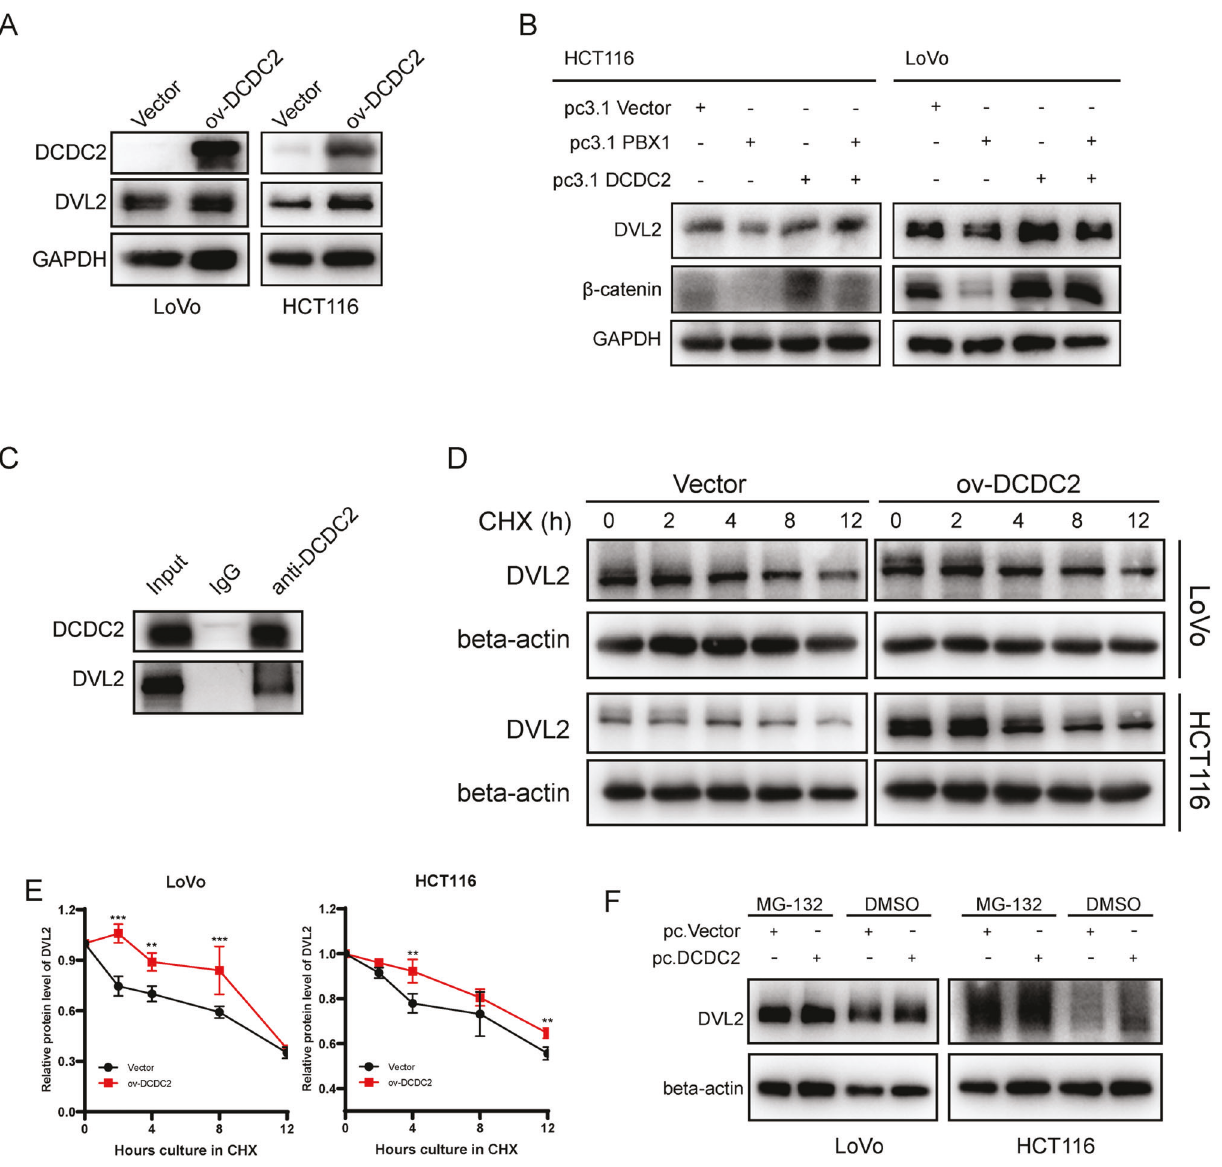
Fig. 7 PBX1-DCDC2 axis controlled Wnt pathway in CRC. A DVL2 decreased under DCDC2 overexpression as measured by western blotting assay. B Western blotting assays detected the DVL2 and β -catenin levels of samples from Fig. 6A. C Co-IP experiments indicated that